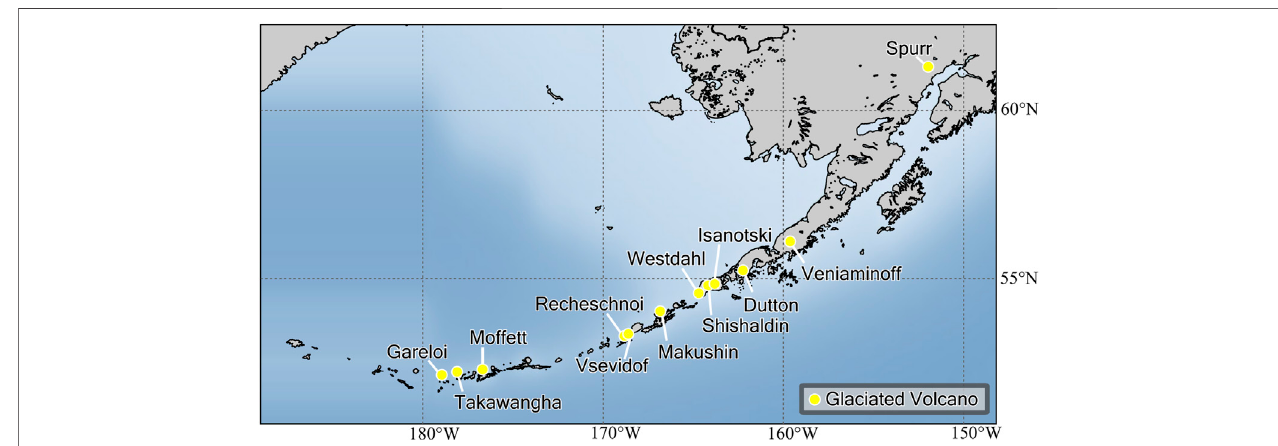
FIGURE 1 | Map of Aleutian Arc, Alaska with glaciated volcanoes represented with yellow circles. Glaciated volcanoes from left to right are Gareloi, Takawangha, Moffett, Vsevidof, Recheschnoi, Makushin, Westdahl, Shishaldin, Isanotski, Dutton, Veniaminof, and Spurr.